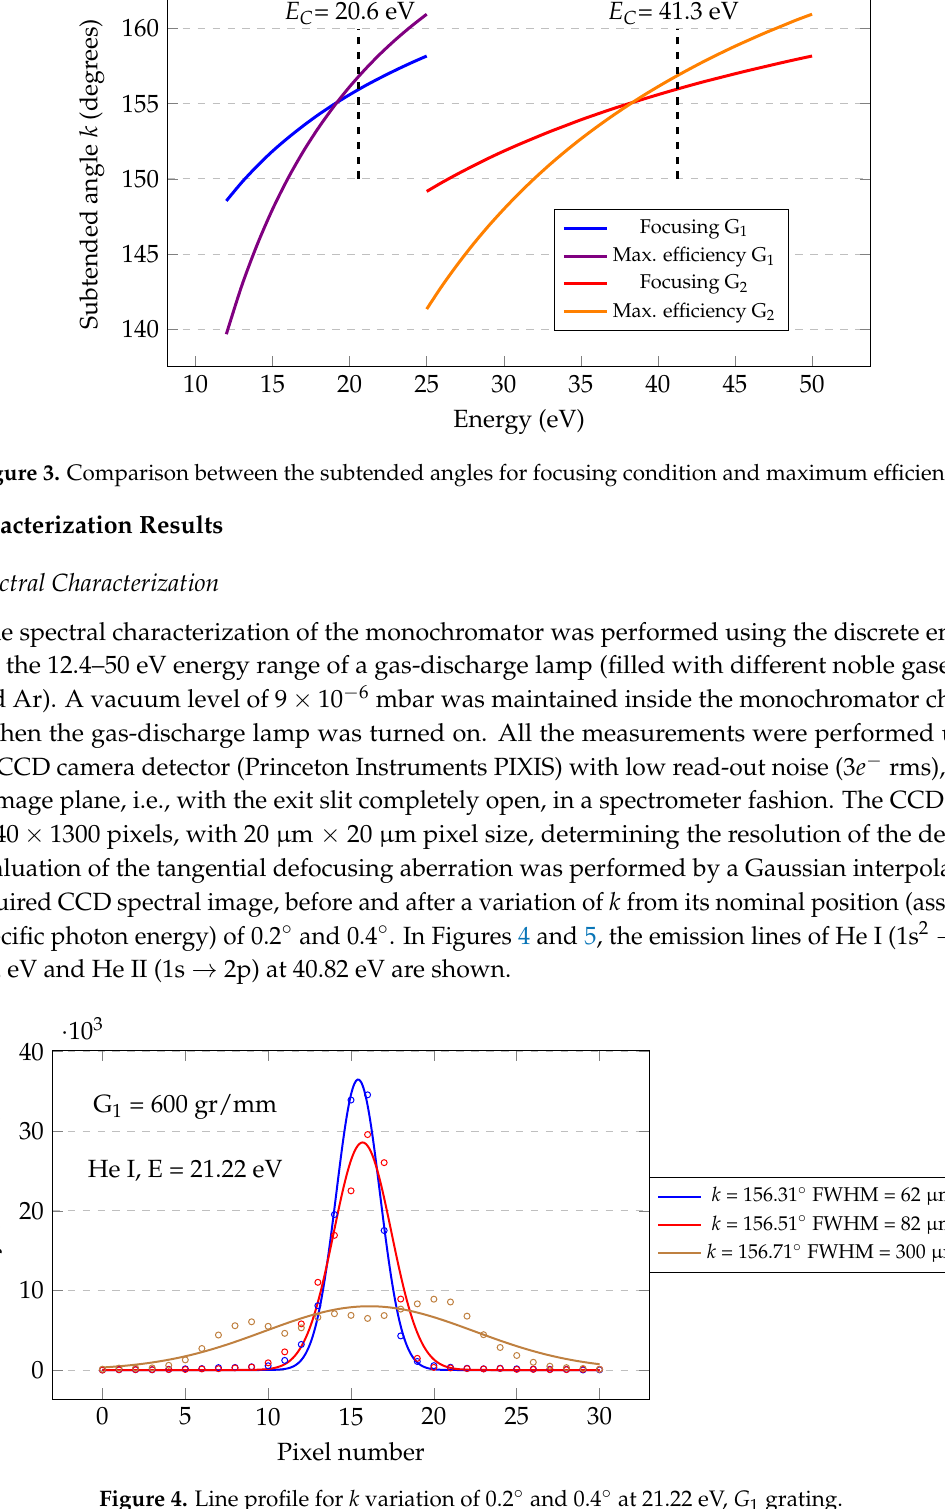
Figure 4. Line profile for k variation of 0.2 ◦ and 0.4 ◦ at 21.22 eV, G 1